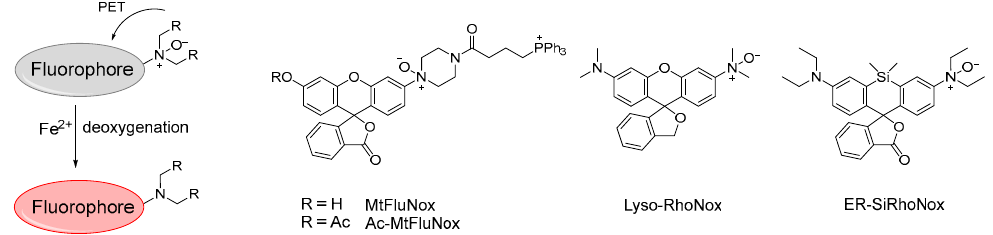
Figure 3. Structures of organelle − targetable Fe 2+ probe MtFluNox, Lyso − RhoNox, ER − SiRhoNox and their general response mechanism to Fe 2+ [42].